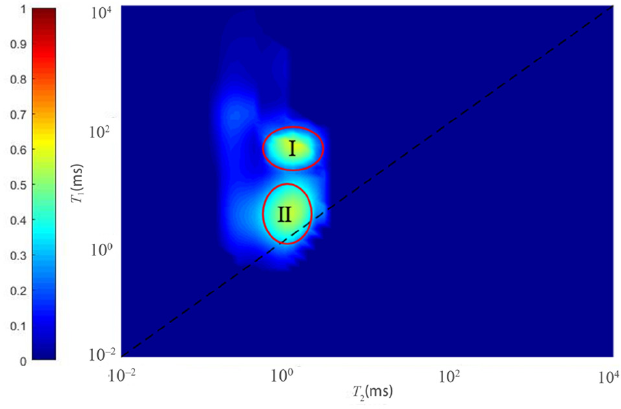
Figure 8. Two regions in the T 1 - T 2 map of inter-salt shale saturated with D4.